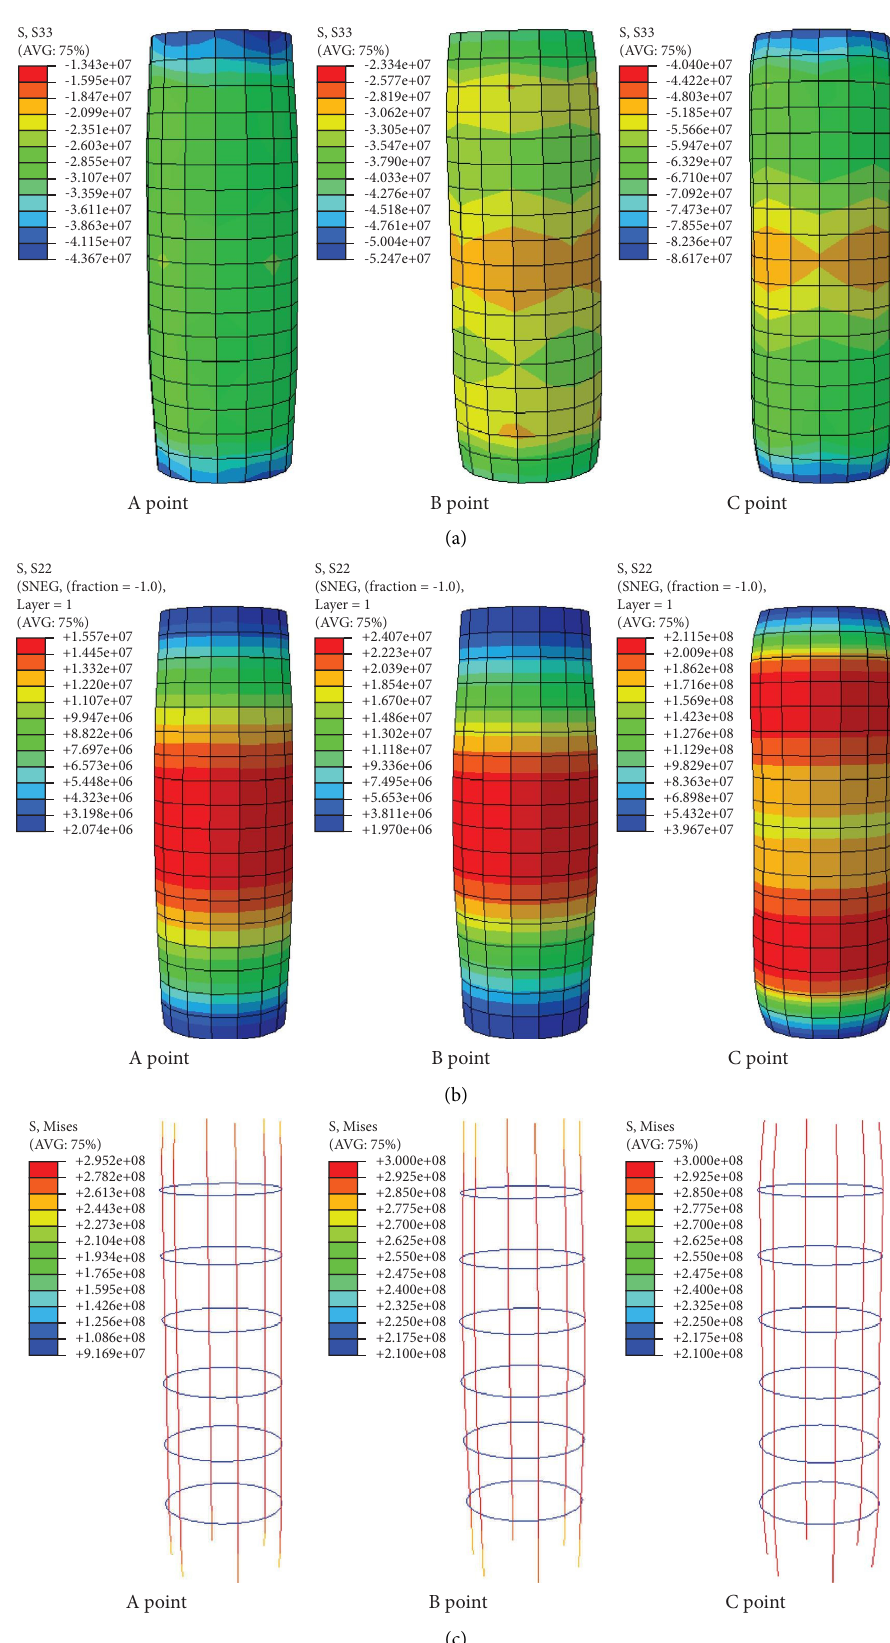
Figure 10: Te stress distribution of each part. (a) Te axial stress distribution in the core concrete. (b) GFRP pipe ring to the stress distribution. (c) Te stress distribution of the reinforced